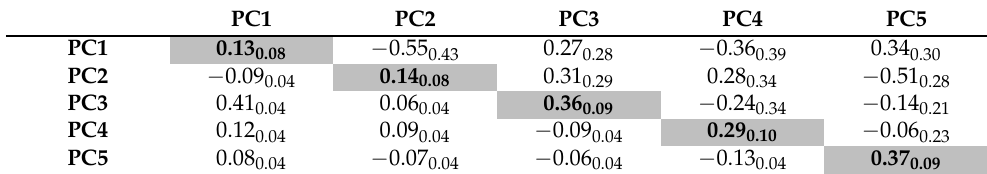
Table 8. Genetic correlations (above the diagonal), heritabilities (in the grey-coloured diagonal) and phenotypic correlations with their standard errors (below the diagonal) for the relative warp scores derived from the horse shape space